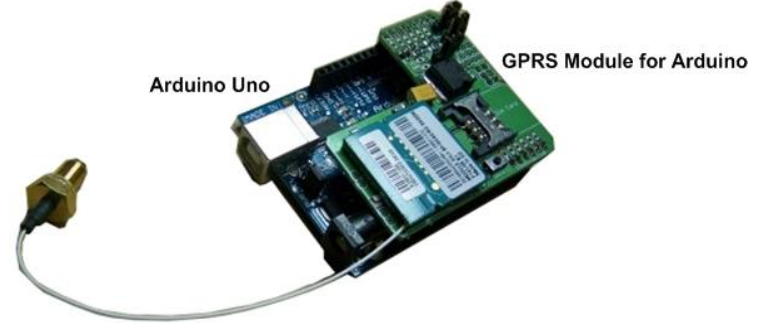
Figure 9. Arduino system employed for communication with the base station, likewise for message